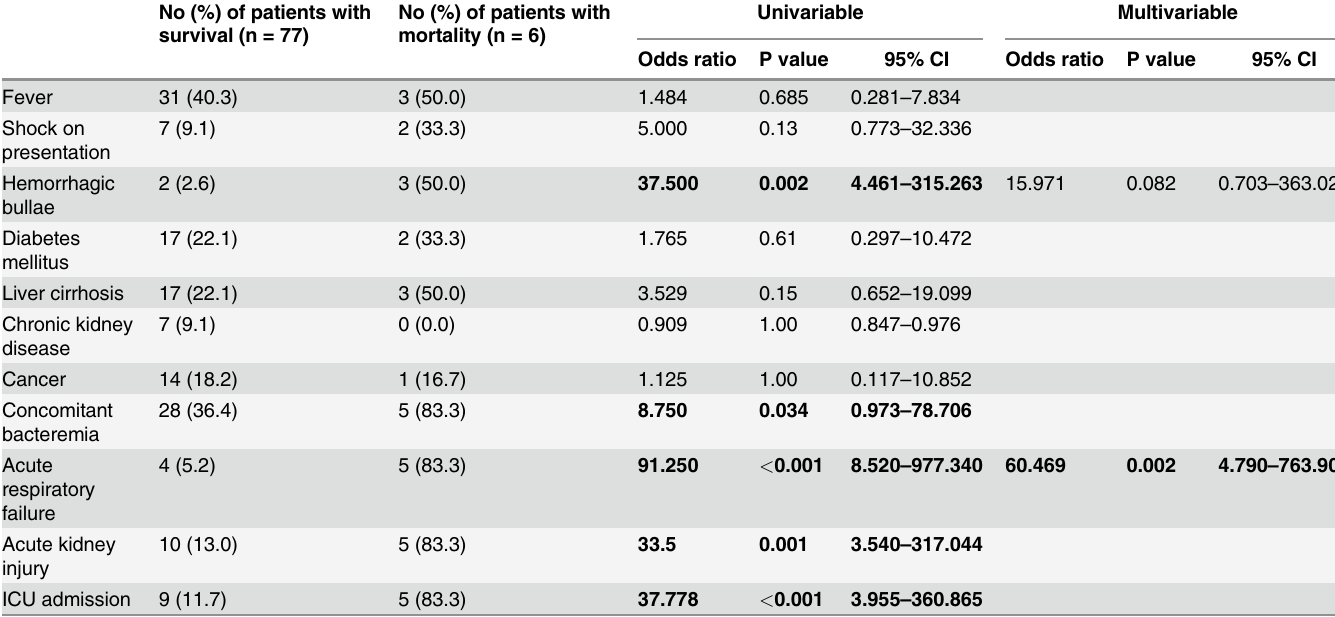
Table 2. Comparison between patients with survival and mortality. No (%) of patients with No (%) of patients with survival (n = 77) mortality (n =